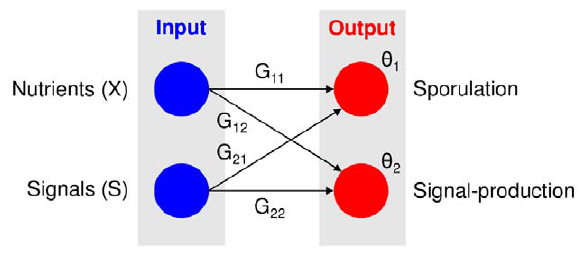
Figure 2. Regulatory network that regulates cell differentia- tion. The left side shows the environmental cues that a cell can sense (the blue nodes): the nutrient concentration ( X ) and the amount of signal ( S ). The right side shows the different cell types into which a cell can differentiate (the red nodes). A cell could differentiate into a sporulating or signal-producing cell. Each connection ( G ij ) shows how the associated environmental cue affects the differentiation process ( black arrows). Each activation threshold ( h j ) shows how much stimulus is required before the associated cell differentiation process occurs. The regulatory network corresponds to inequality 1a and 1b, which are described in the main text.